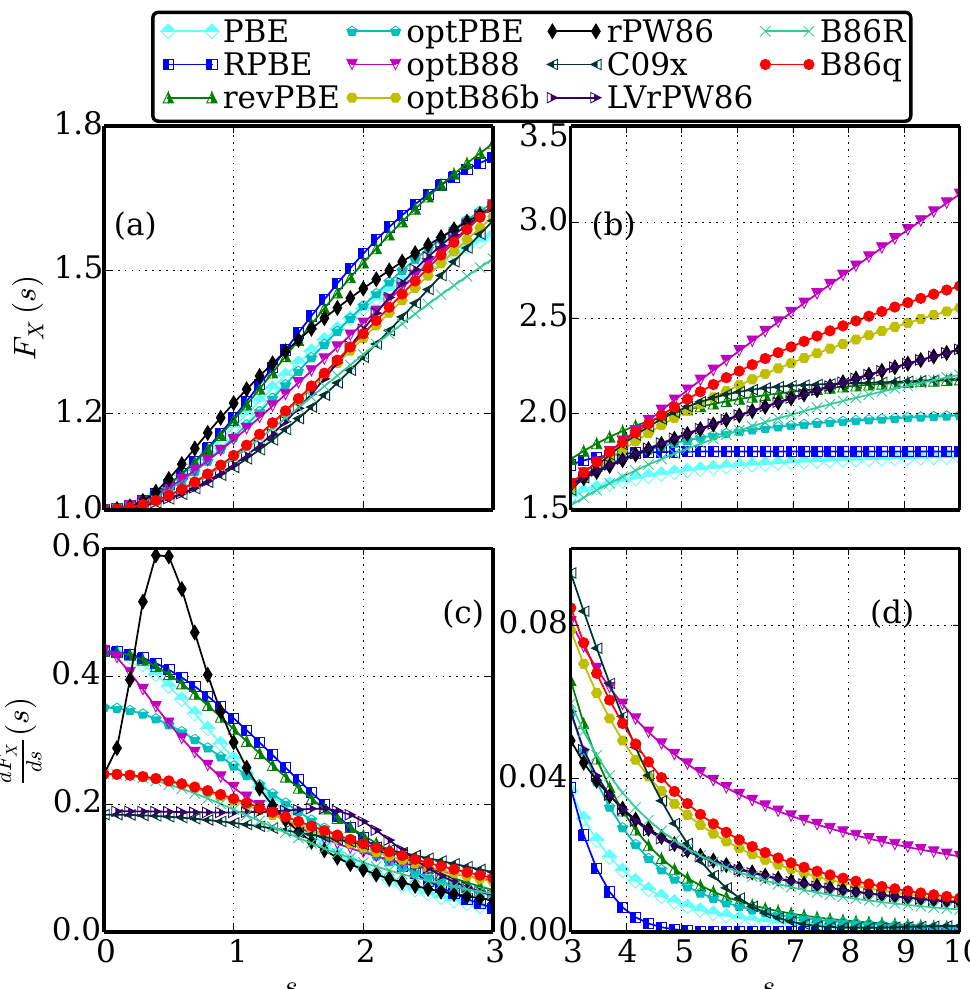
Figure 2. Enhancement factors. The exchange enhancement factor F X as a function of reduced density gradient s for 11 exchange functionals in GGA formula in the range of ( a ) 0–3 for low-gradient domain and ( b ) 3–10 for high-gradient domain. The vdW-DFq used the optB86b exchange energy with q = 1.05. F X as a function of s are illustrated in the range of ( c ) 0–3 and ( d ) The derivatives d ds